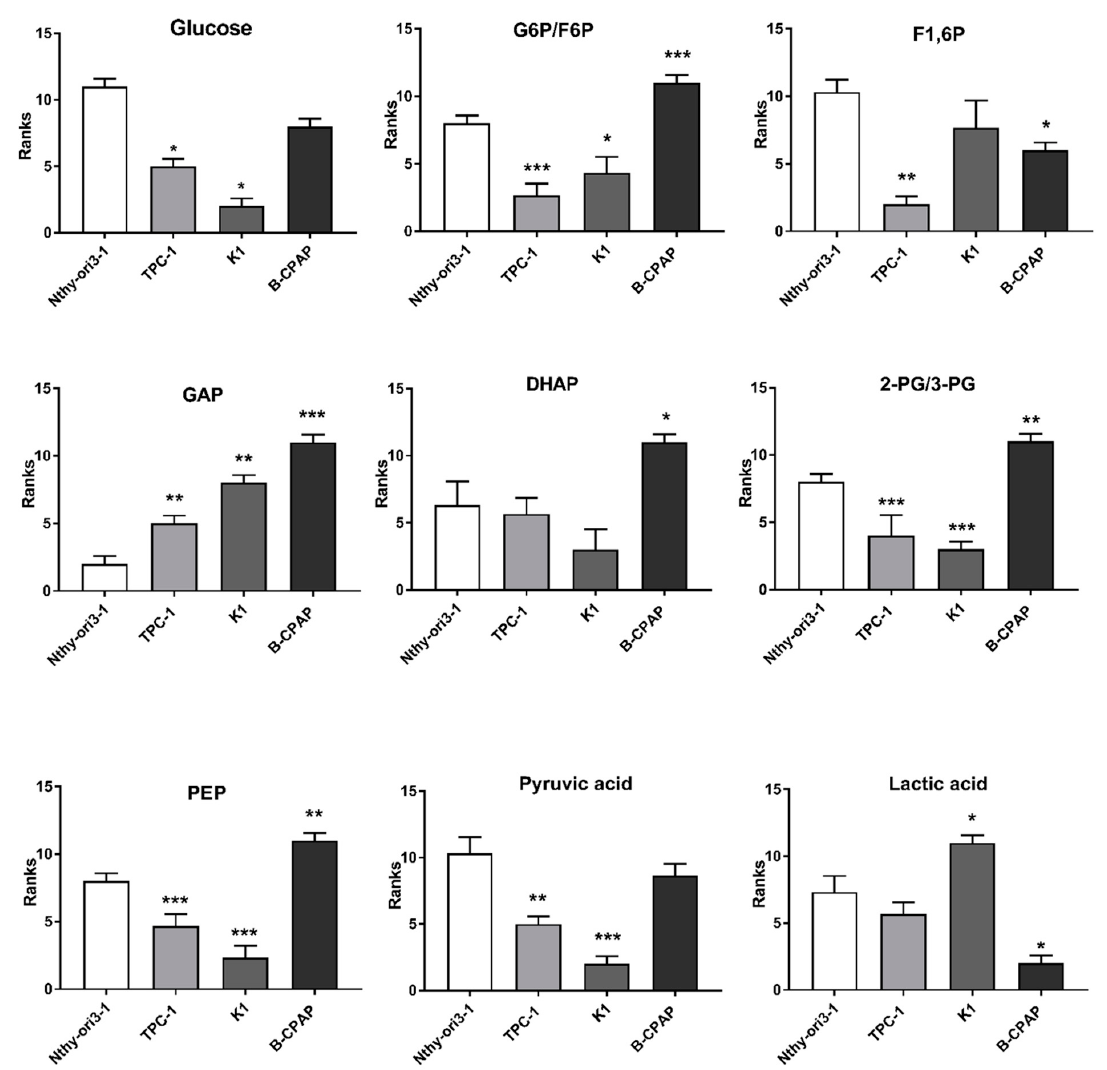
Figure 1. Glycolytic Pathway in PTC-derived cells . Metabolic alterations in glycolysis measured using ultra-high performance liquid chromatography–tandem mass spectrometry (UHPLC-MS/MS). Bar graphs indicate the relative concentration (peak areas) of the metabolites expresses as ranks. All experiments were performed three times independently, each time in triplicate to confirm the results. Statistical analyses were performed by Student t -test. Results were considered significant when * p < 0.05, ** p < 0.01, *** p < 0.001.